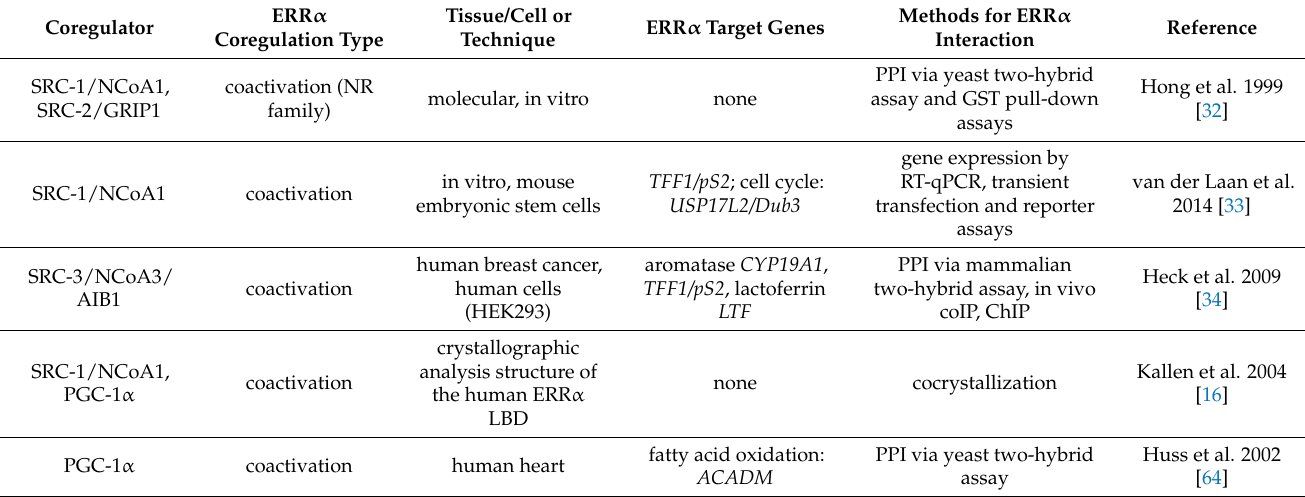
Table 1. Summary of known ERR α coregulators and their associated target